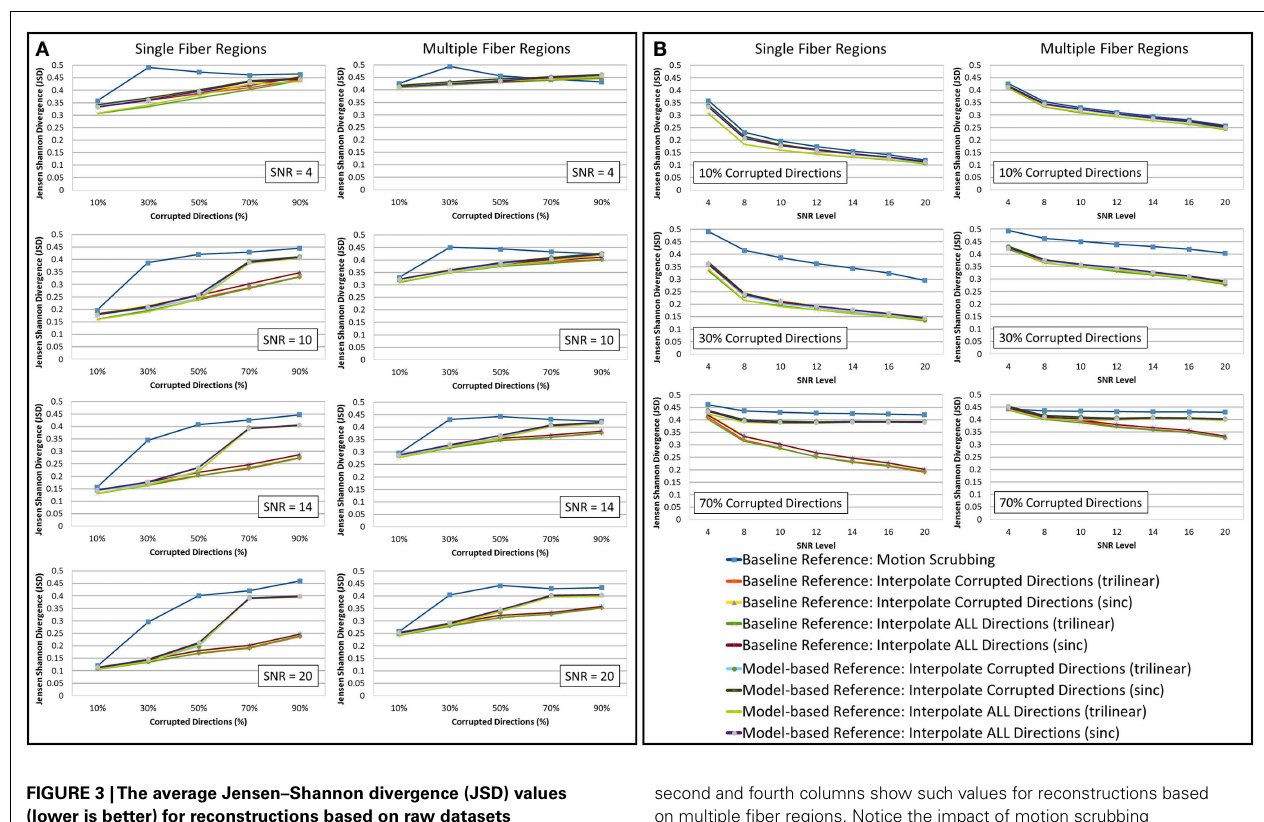
FIGURE 3 |The average Jensen–Shannon divergence (JSD) values (lower is better) for reconstructions based on raw datasets (denoised ones share similar performance) as (A) a function of motion corrupted percentage for different SNR levels and (B) a function of SNR levels for different motion corrupted percentage . The first and third columns show JSDs single fiber regions while the